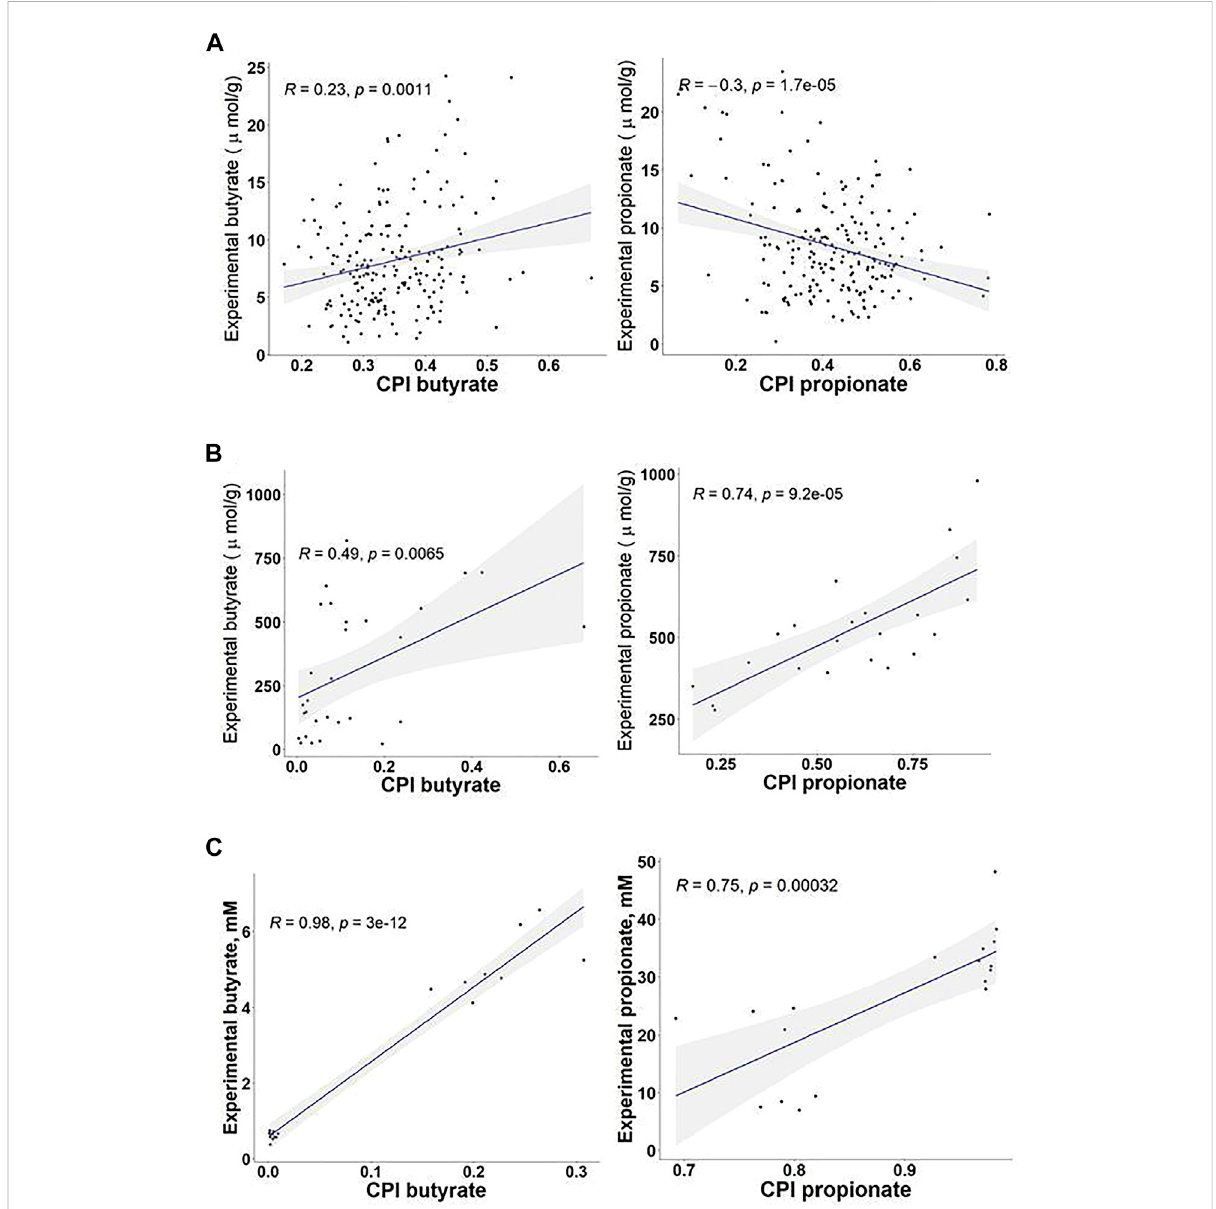
FIGURE 6 Correlations between Community Phenotype Indices (CPI) for butyrate and propionate production and the experimentally measured concentrations of SCFAs in 16S metagenomics studies of HGM. (A) In vivo study of the effects of dietary fi bers on fecal microbiota of 200 healthy individuals(Deehanetal.,2020). (B) Invitro batchfermentationstudyoftheeffectof fi bersonHGMmicrobiota(ChenM.etal.,2020). (C)